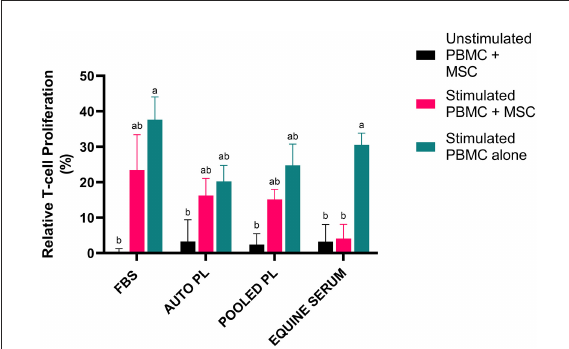
FIGURE4 Representation of mean ( ± SEM) proliferation of CD3 + T cells as measured by flow cytometry using CFSE quantification. Peripheral blood mononuclear cells (PBMCs) were co-cultured with BM-MSCs in each media type and stimulated with (stimulated) or without (unstimulated) Con A. Proliferation was normalized by dividing by proliferation of unstimulated PBMCs cultured alone in the respective media type (Relative T cell proliferation %). Comparisons were made within and across all groups and conditions. Different letters denote significant differences between groups; p < 0.05 ( n = 6). FBS, fetal bovine serum; PL, platelet lysate; auto,